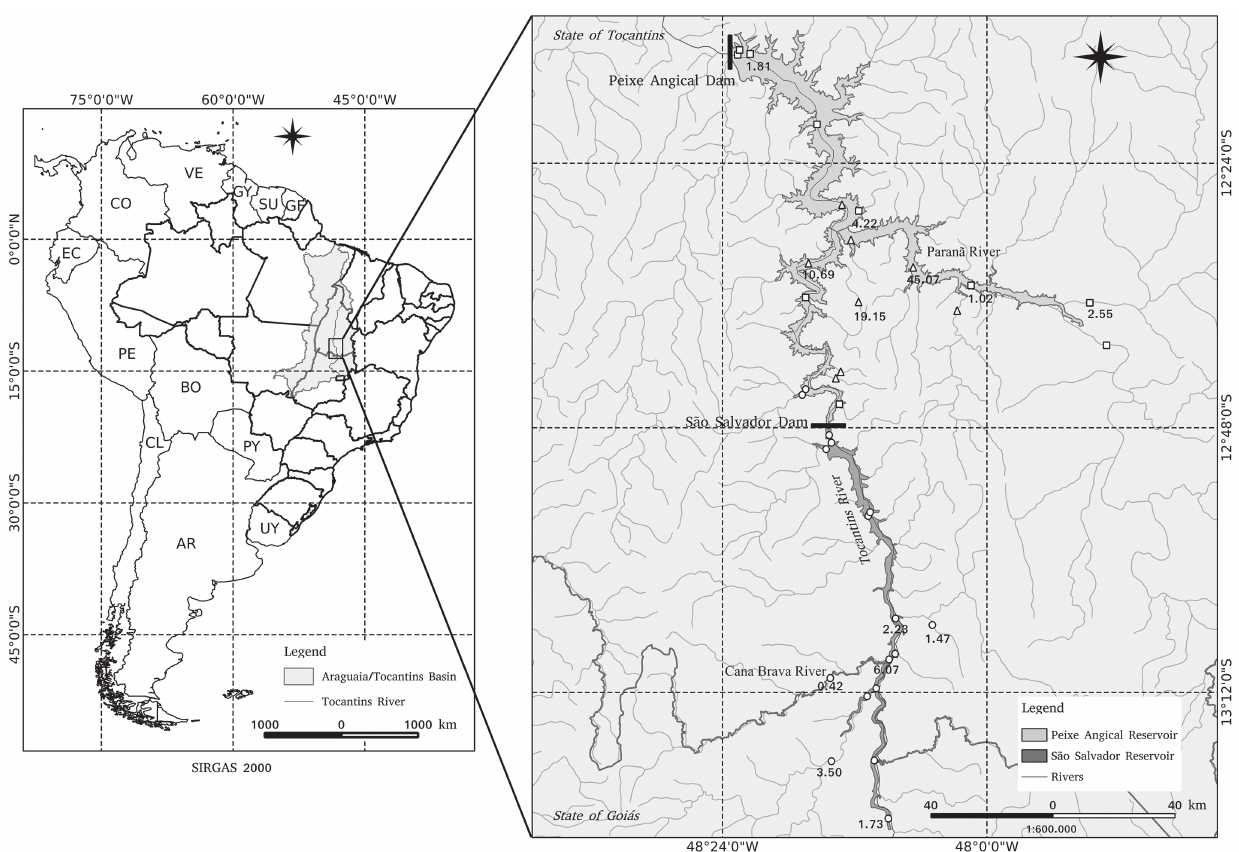
Fig. 1. Study area on the upper rio Tocantins, monitored between 1998 and 2009. Sampling sites of each data set are indicate by different symbols (Data Set 1 = triangles; 2 = squares; 3 = circles). Numbers near sampling sites are the relative abundance (%) of Mylesinus paucisquamatus over the whole study